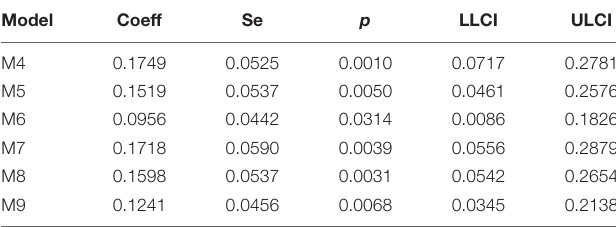
TABLE 4 | Robustness test by